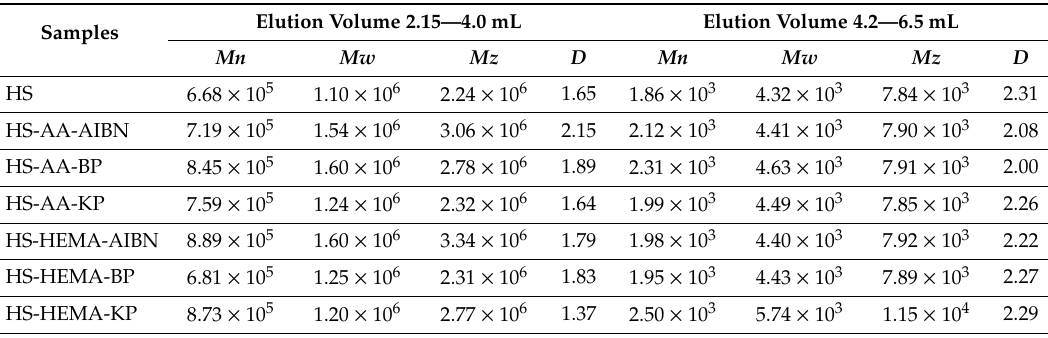
Table 5. Di ff erent molar masses (g / mol) of HS and copolymers (AA and HEMA).